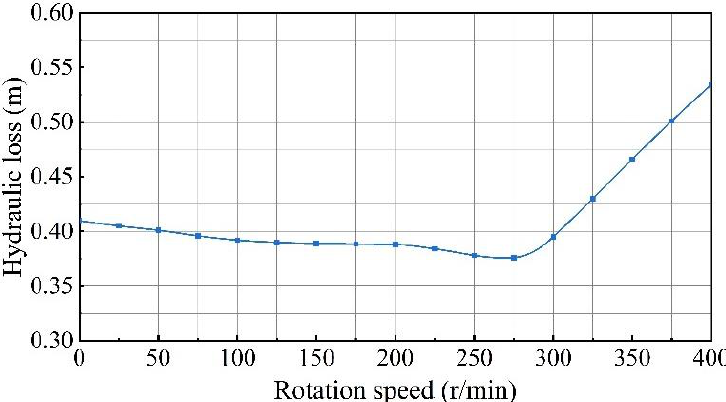
Figure 10. Numerical results of hydraulic loss in outlet conduit under different inlet water rotation speeds.